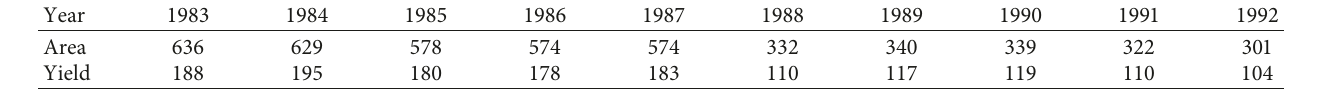
Table 1: Statistics on the total output of food crops (ten thousand mu, ten thousand